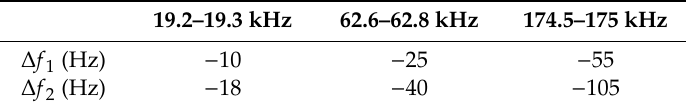
Table 3. Peak frequency shifts at different frequency bands.